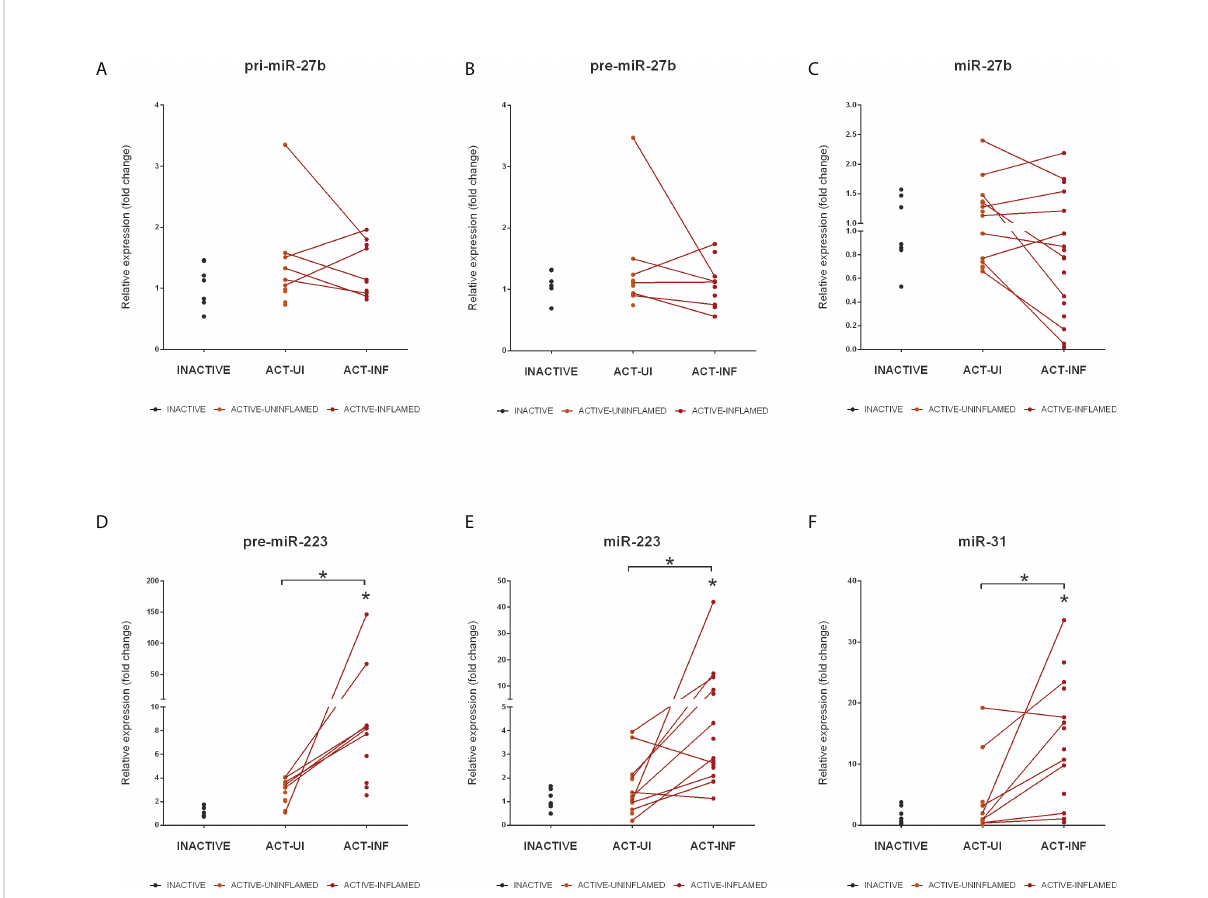
FIGURE 5 Expression changes of miR-27b, miR-223 and miR-31 in the in fl amed colons of IBD patients. Relative expression of pri- (A) , pre- (B) and mature (C) miR-27b, pre- (D) and mature (E) miR-223 and mature miR-31 (F) is shown from inactive (grey), active unin fl amed (orange) and active in fl amed (red) colon samples of IBD patients. Dots represent individual values; data are presented as the mean ± SEM. Lines connect unin fl amed and in fl amed samples from the same IBD patient; * p